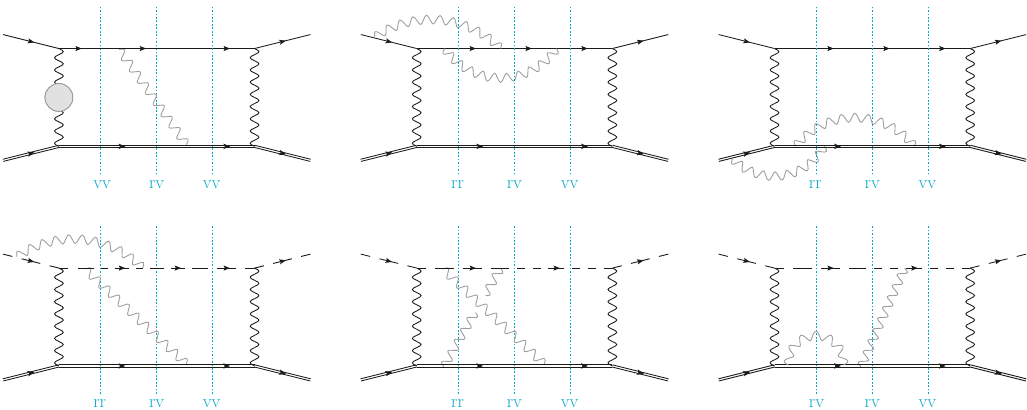
Figure 1 . Sample contributions to the (squared) matrix elements M (2) n (vv), M (1) M (0) (rr). The leading order part M (0) n ∼ q 2 Q 2 is shown in black while additional particles are n +2 shown in grey. The top-left panel shows fermionic corrections. Electronic (muonic) corrections are shown in the top-middle (right) panel, with all additional emissions ∼ q 4 ( ∼ Q 4 ) from the electron (muon) line. Muon mass effects (solid double line) and electron mass effects (single solid line) are taken into account exactly. The bottom panel shows examples of mixed corrections, with additional couplings q 3 Q (left panel), q 2 Q 2 (middle panel), and q Q 3 (right panel). For these contributions electron mass effects in M (2) n (vv) are included only through massification (see text), as indicated by the dashed single